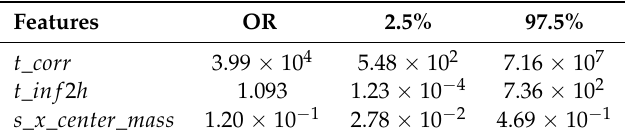
Table 2. Odds Ratio (OR) values from the model obtained by NC method.